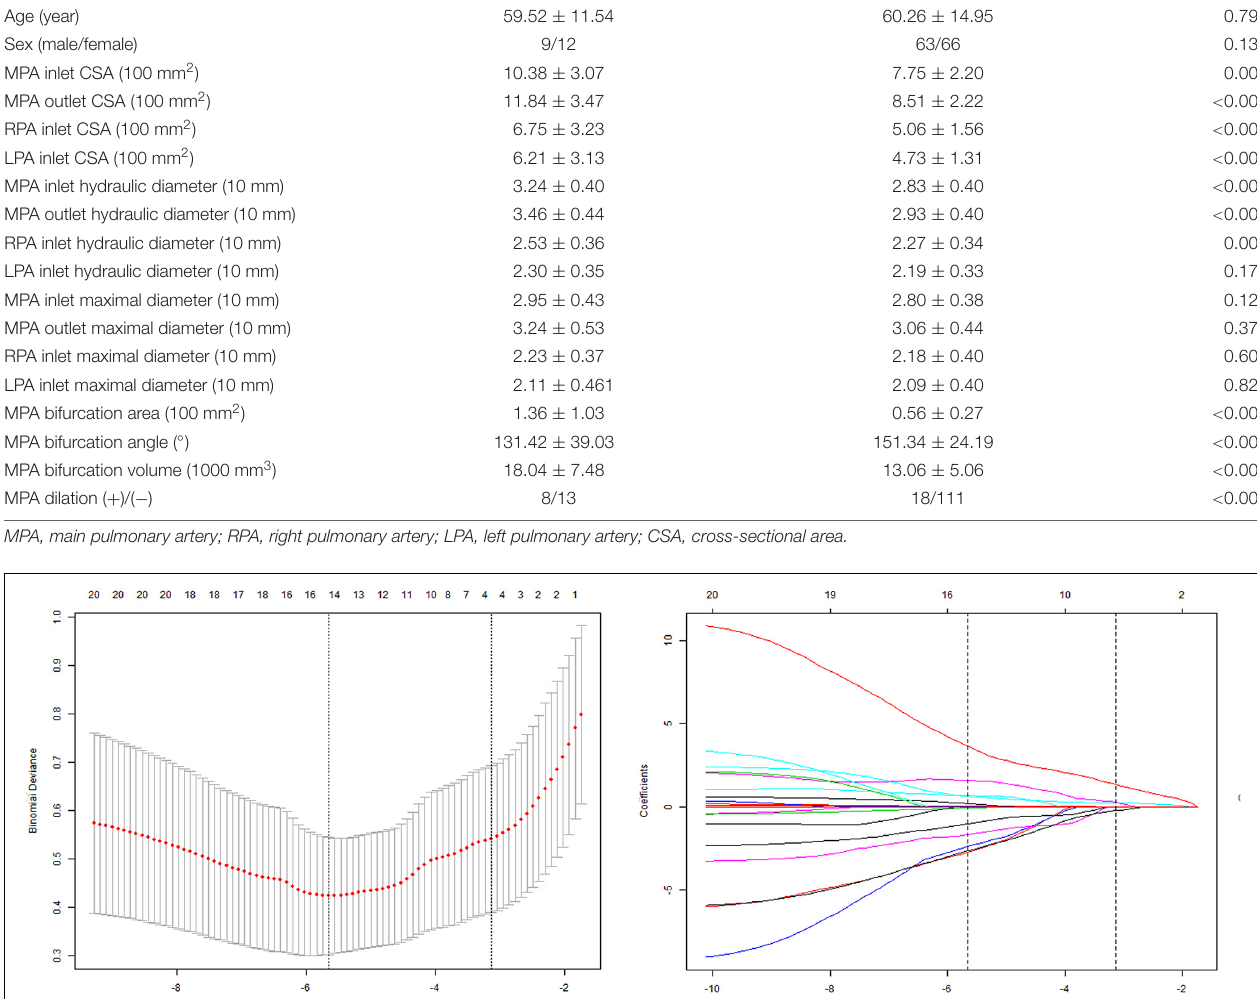
TABLE 4 | Comparison of parameters between adverse events ( + ) patients and adverse events ( − ) patients in the training set. Parameter Adverse events ( + ) ( n = 21) Adverse events ( − ) ( n = 129)